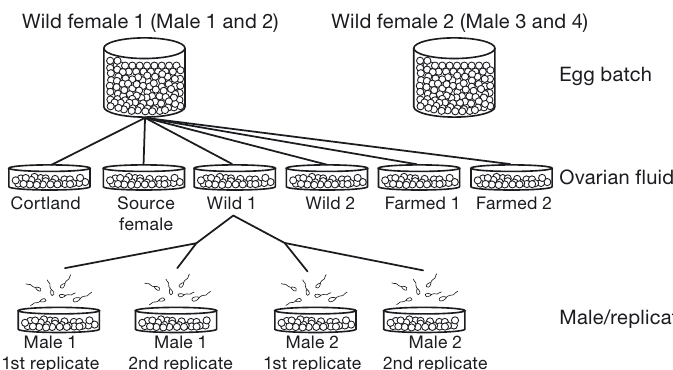
Fig. 1. Schematic representation of the experimental design of the sperm fertilization-capacity experiment (Expt 2); the top row represents the 2 batches of eggs collected on different days, the middle row represents the 6 treatments (egg-source ovarian fluid replaced by different origin ovarian fluid or Cortland solution), and the bottom row represents the males and replicates used in each egg batch and ovarian fluid